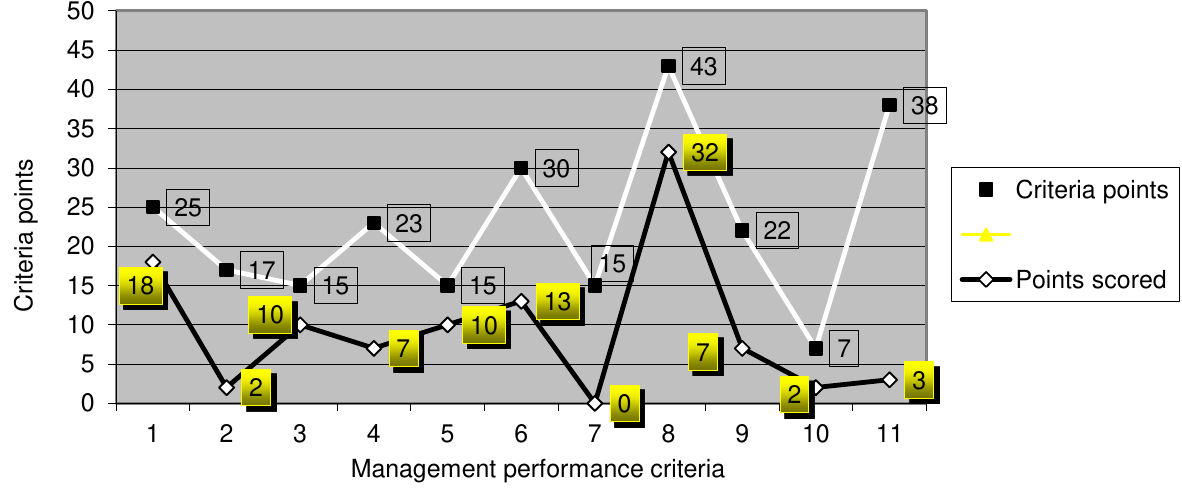
Fig. 3. Worldclass best practice versus respondents ’ Criteria